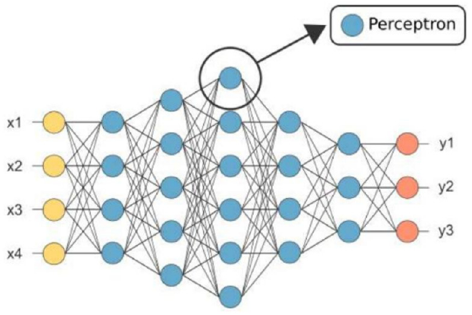
Figure 4. Topology of neural network structure.